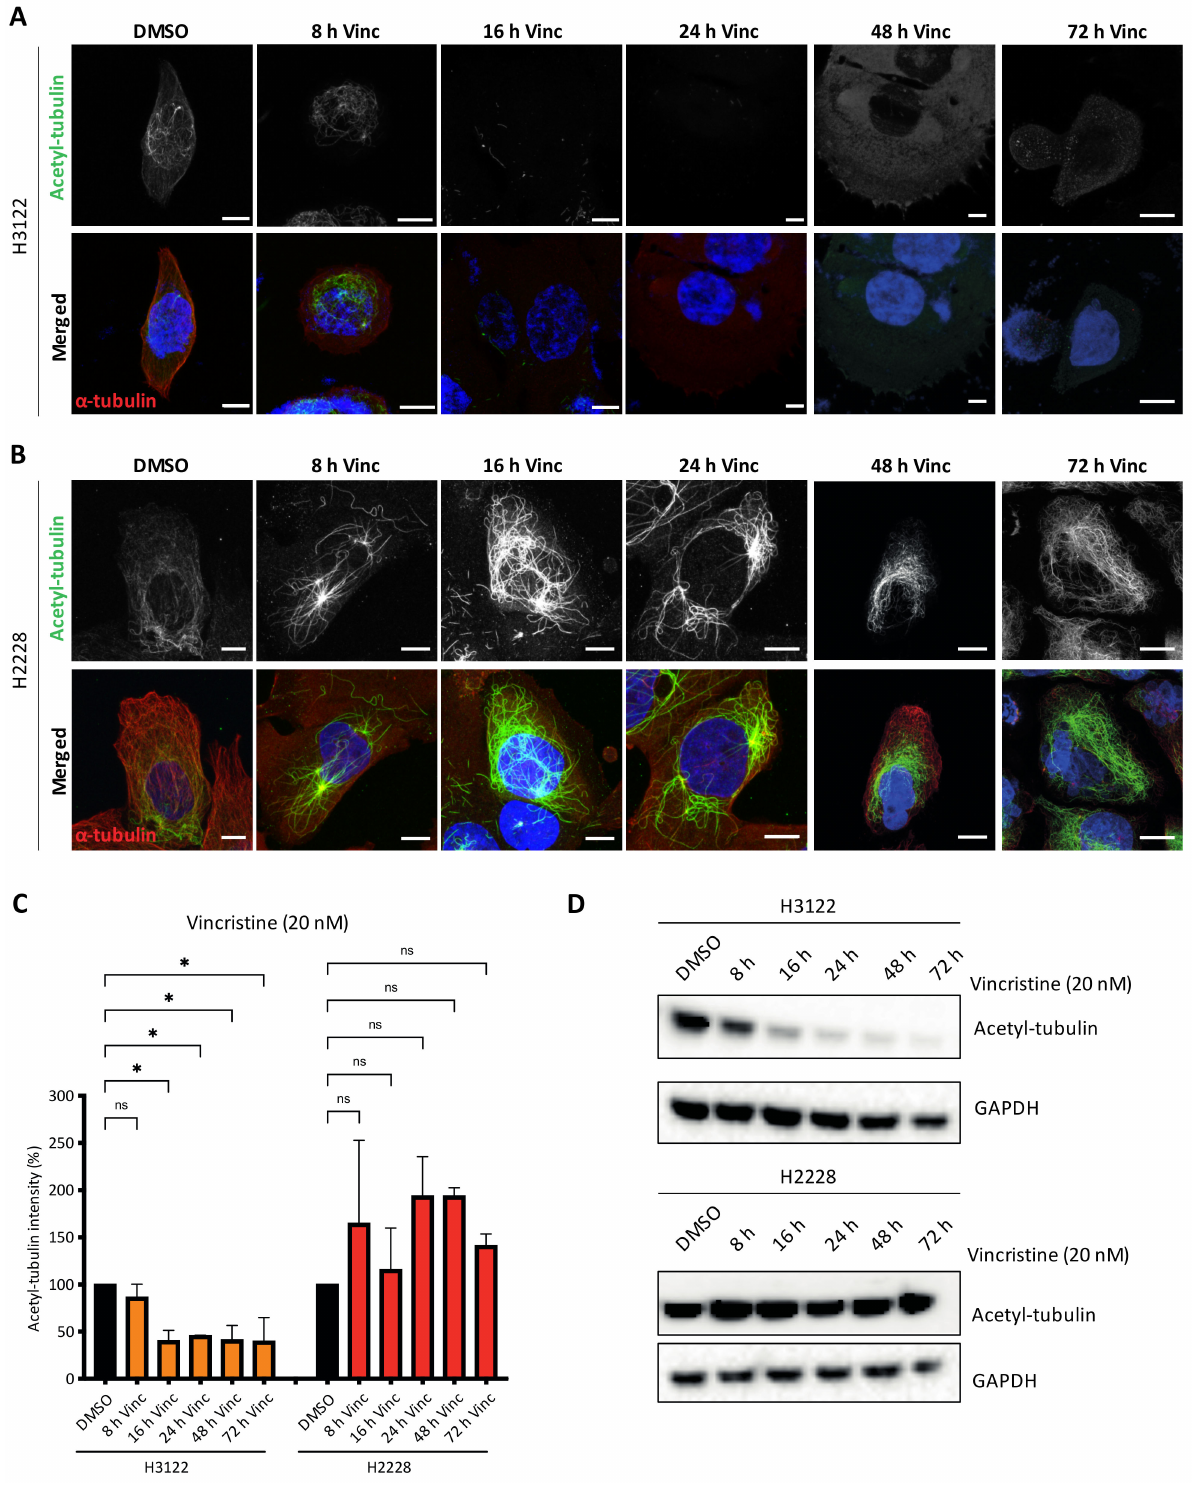
Figure 4. Vincristine treatment reduces tubulin acetylation in H3122, but not in H2228 cells. ( A , B ). H3122 and H2228 cells were treated with vincristine (20 nM) at the indicated time points before fixated and stained with anti-acetylated tubulin (green), anti- α -tubulin (red) and DAPI (blue). Scale bars, 10 µ m. ( C ). Box plot shows the intensity of acetylated tubulin from ( A , B ). Data represent counts from >20 cells, n = 2. ( D ). H3122 and H2228 cells were treated with vincristine at the indicated time points. Western blots of acetylated tubulin are shown. GAPDH was used as a loading control. * p < 0.05, ns = not